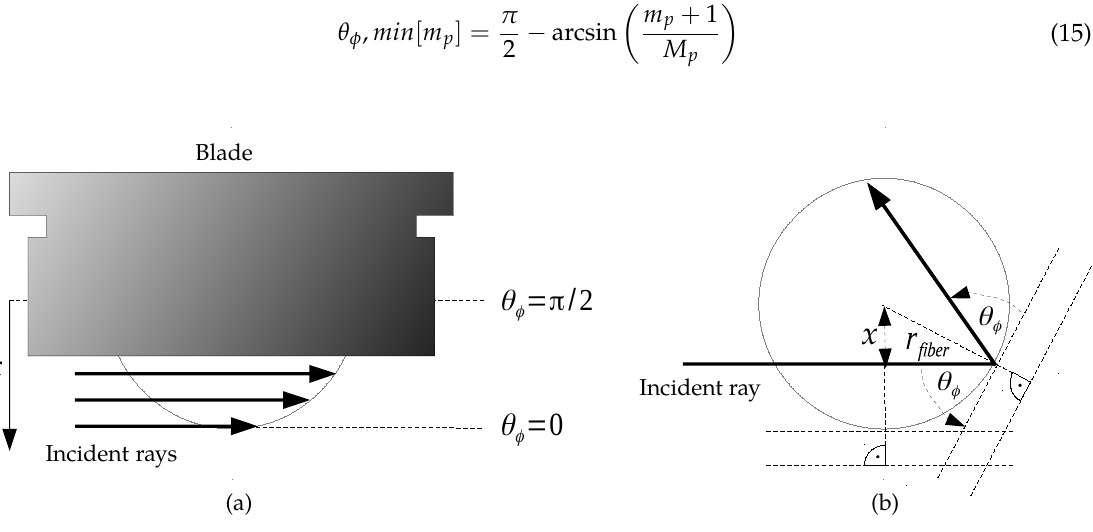
Figure 5. Covering the front surface of a fiber ( a ) to influence the possible θ φ range ( b